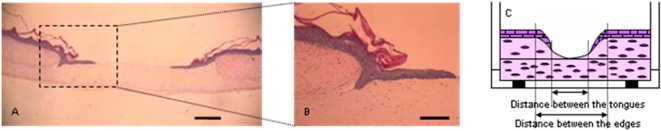
Hematoxylin and Eosin staining of wounds (A,B) shows epithelial tongues migrating across the wound bed to close the wound.C is a schematic figure of the wound. The distance between the wound edges and between the epithelial tongues is measured to determine the percentage of wound closure. The scale bar in A,B is 500 µm, on figure C the scale bar is 100 µm.